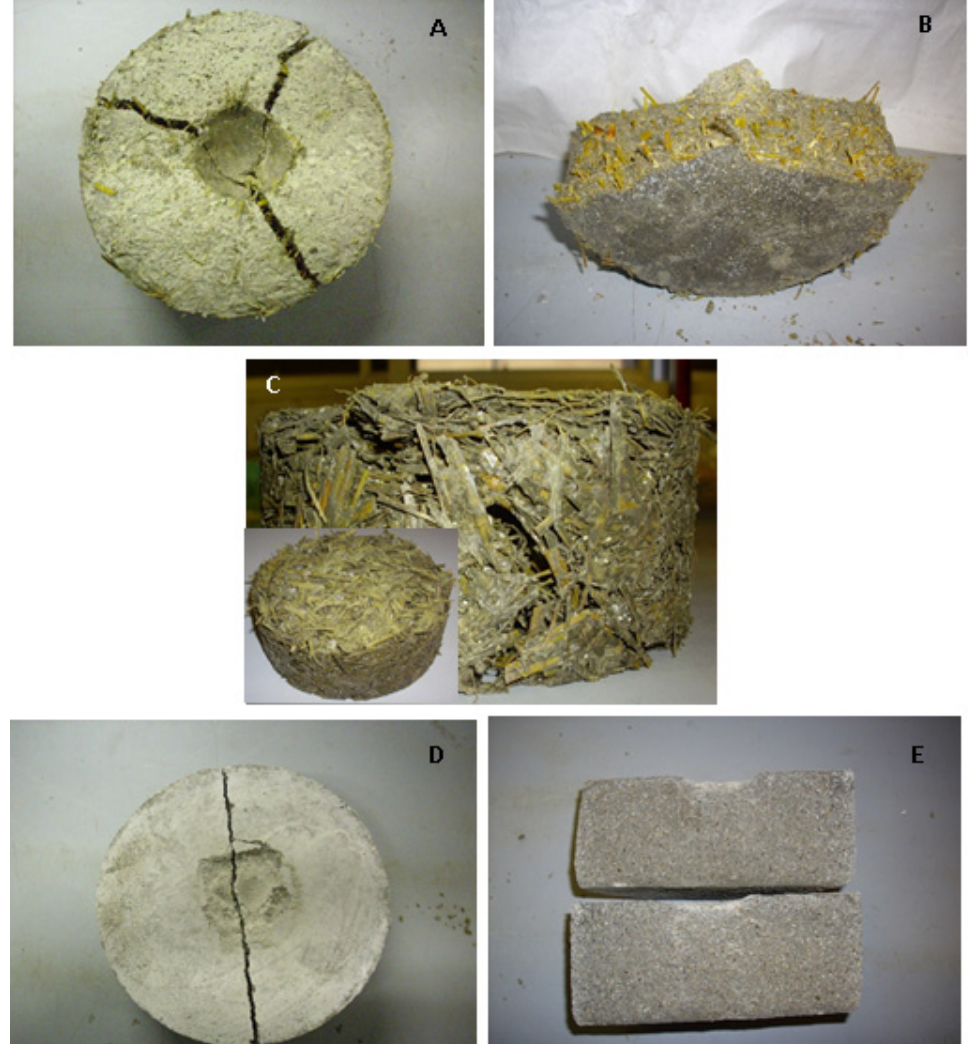
Figure 12. Samples after the impact test. ( A , B ) S3 sample, ( C ) S3C sample, ( D , E ) perlite sample.